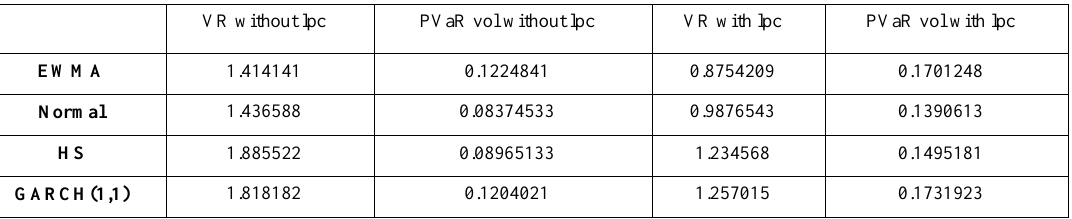
Table 2. Backtesting with and without lpc for PVaR NBG